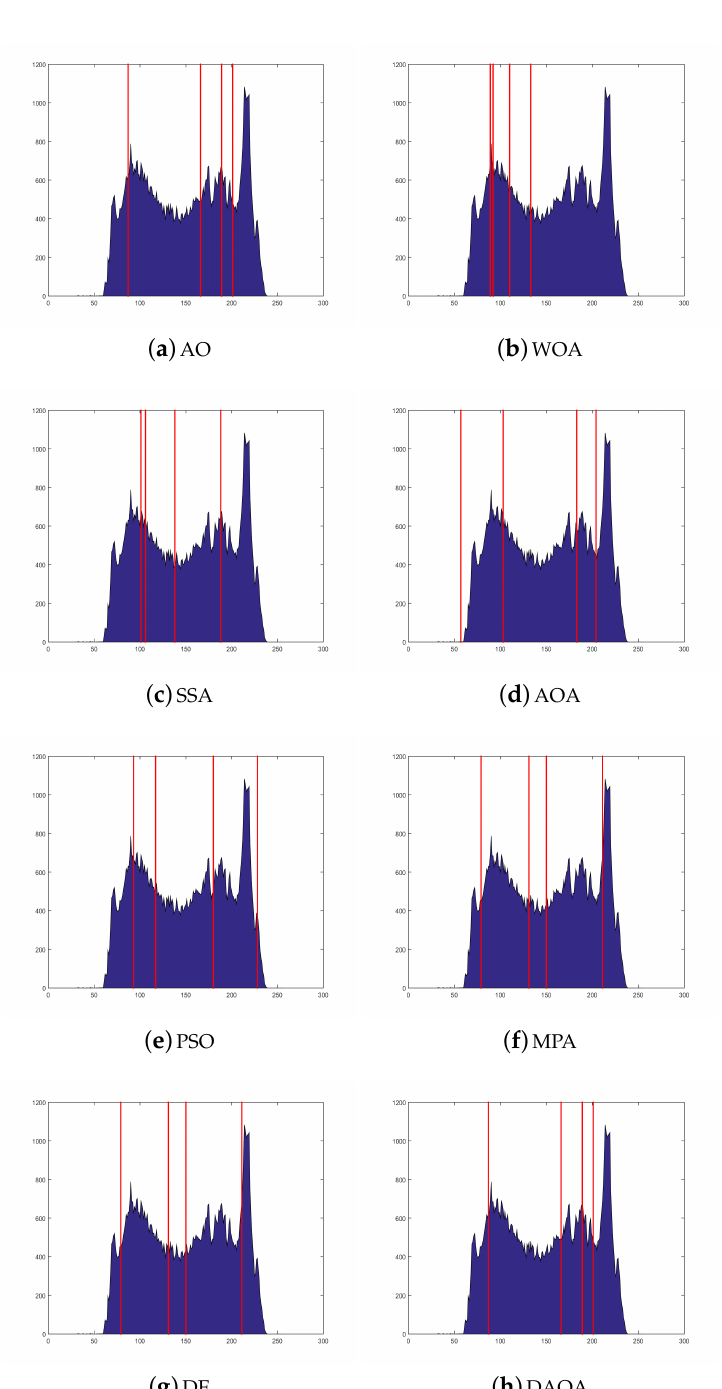
Figure 13. The histogram image (Test 8) by the comparative methods when the threshold value is